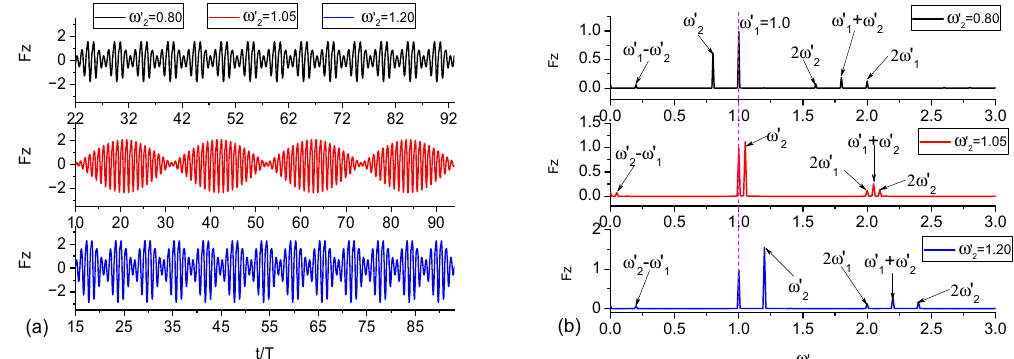
Figure 9. Vertical force histories and their amplitude spectral analysis of heave motion with two frequencies: ( a ) vertical force histories; ( b ) FFT analysis of the vertical forces.